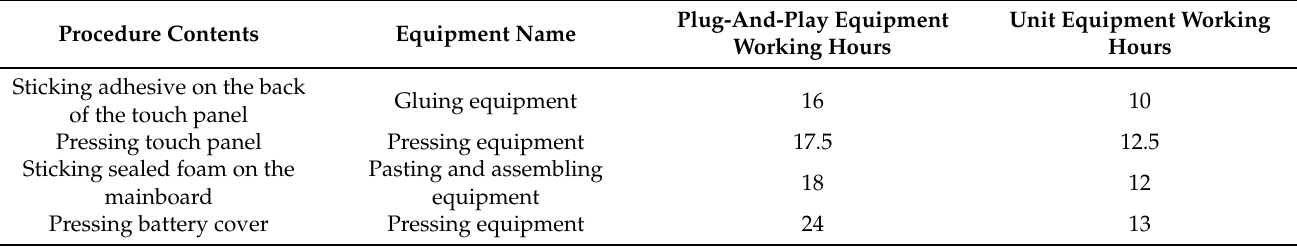
Table 3. Working Hours Design of Automation Process.